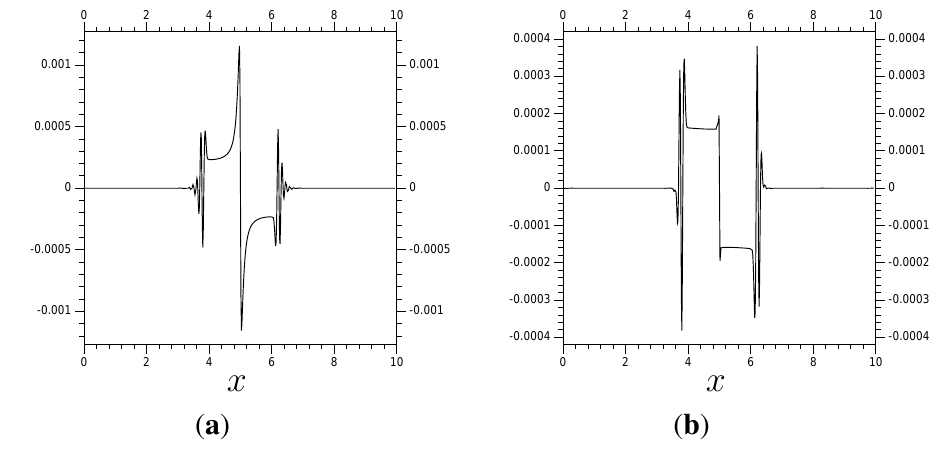
Figure 7. Results of a multi-scale system for Burgers’ equation compared with a full resolution system. The error shown is the difference between the V − Figure 6 and the full V − resolution results from Figure 3. ( a ) Error at t = 1 . 0 ; ( b ) Error at 6 t = 2 . 0 .